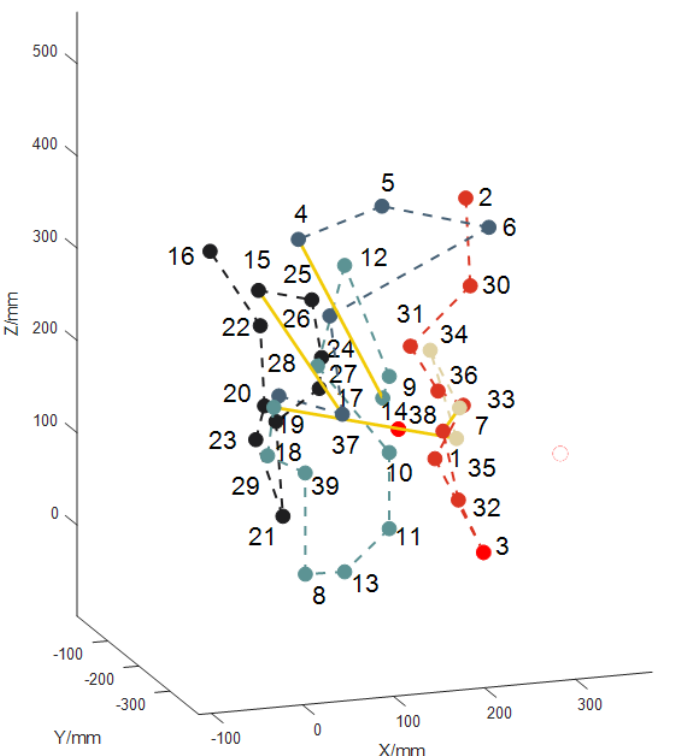
Figure 12. Inter-group and intra-group inspection sequence diagram, different color dots represent the MPs within different groups, the dotted line denotes the intra-group inspection sequence, the solid yellow line denotes the inter-group inspection sequence.